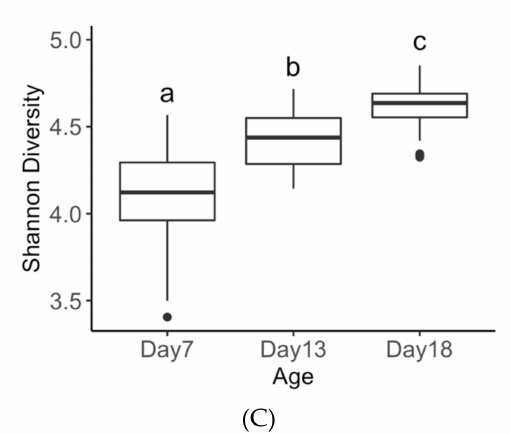
Figure 2. Comparison of bacterial Pielou’s Evenness ( A ), Number of taxa ( B ) and Shannon Diversity ( C ) between piglets at age 7, 13, and 18 days at genus level. Subscripts of di ff ering letters are significantly di ff erent from one another (P <